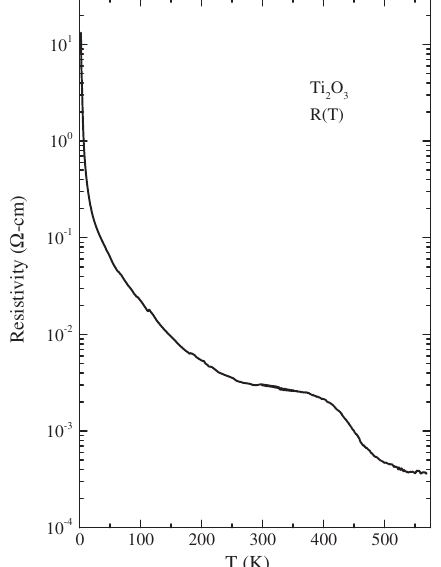
FIG. 5. Temperature-dependent resistivity of Ti 2 O 3 from 10 K to 575 K, showing the insulator-to-metal